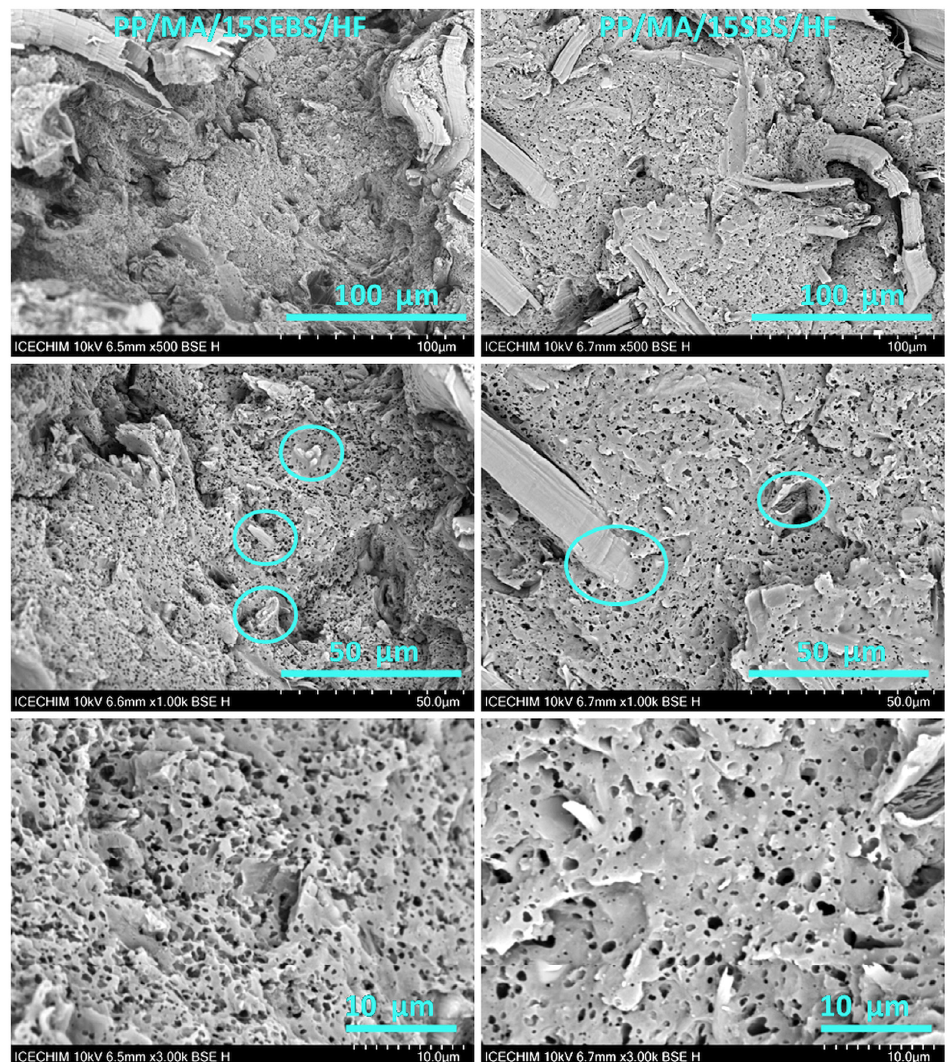
Figure 6. SEM images at different magnification of fractured surfaces of PP/MA/15SEBS/HF and PP/MA/15SBS/HF after etching.